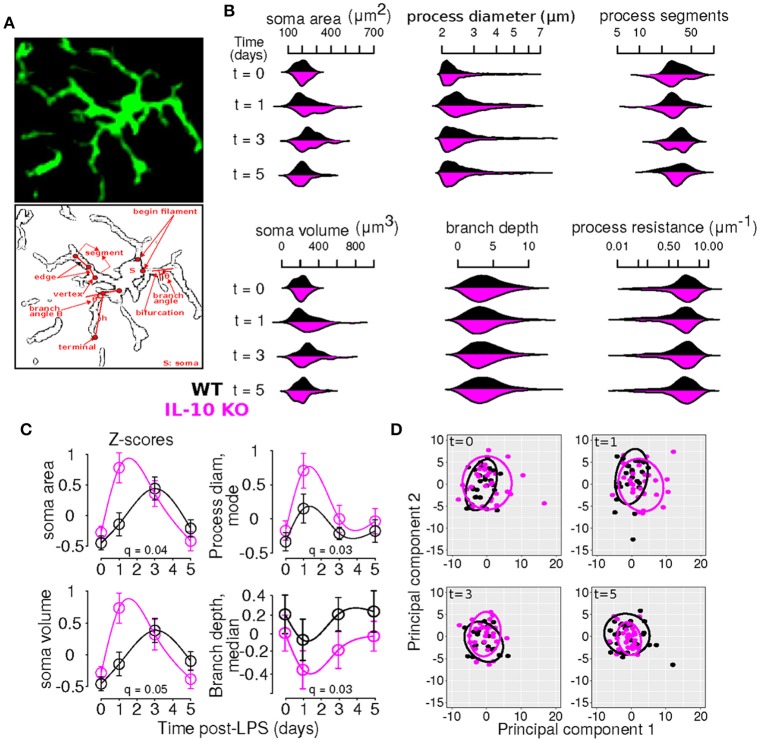
Time-series and multivariate statistical analyses reveal that IL-10 modulates the dynamics of microglial morphology. (A) Panels show an Iba1 stained microglia (top) and a line sketch showing some of the main morphological features analyzed (bottom). (B) Kernel density plots show the distributions of various morphological variables as a function of time for WT and IL-10−/− (black and magenta, respectively). These analyses illustrate the relative influence of LPS on morphological properties in WT and IL-10−/− microglia. (C) Morphological features with statistically different dynamic profiles between genotypes were analyzed using the optimal discovery procedure (ODP). Several features showed genotype-specific significant differences. As described in the methods, we used the ODP to compare the temporal profiles of WT and IL-10−/− microglial features and we indicated the false discovery rate adjusted p-values (i.e., q-values) in the four panels; see Table 2 for documentation of all q-values. (D) Principal component analysis of differences in morphological features at various times after LPS administration. Note the difference between the two groups at t = 1 day.